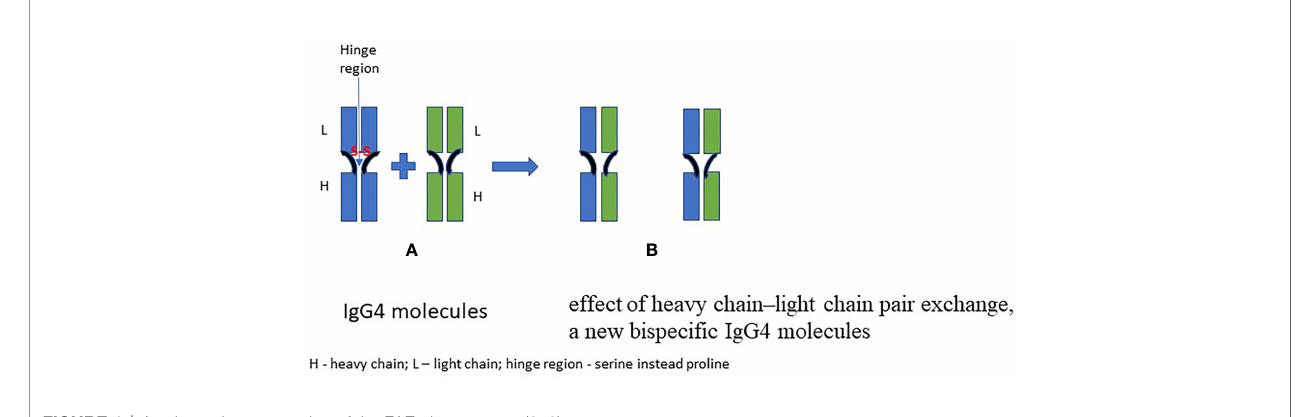
FIGURE 1 | A schematic presentation of the FAE phenomenon